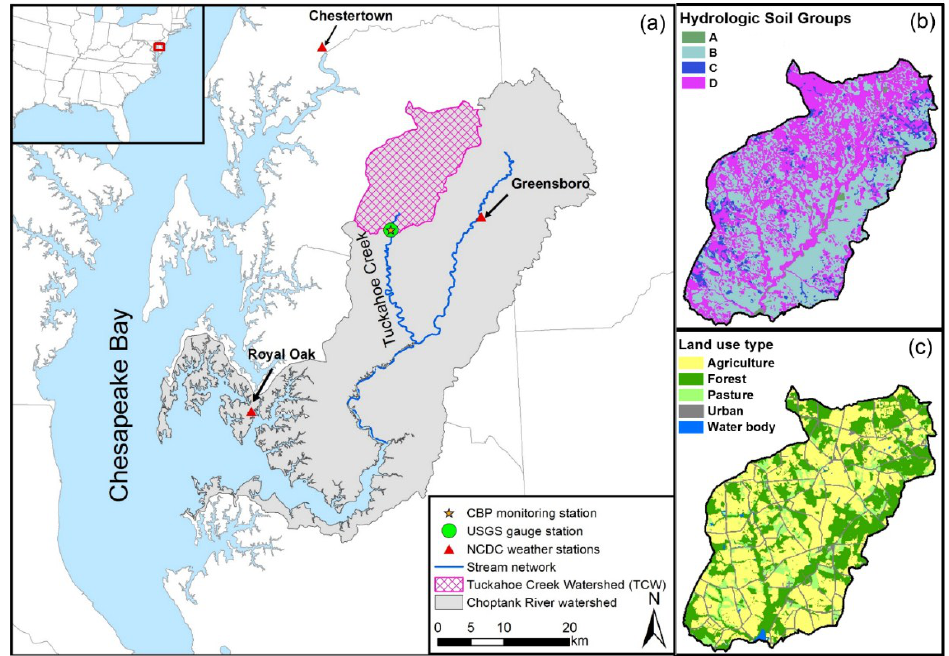
Figure 1. Location ( a ) soil ( b ) and land use ( c ) of the Tuckahoe Creek Watershed (adapted from [22]). HSGs are characterized as follows: A—well-drained soils with 7.6–11.4 mm/h water infiltration rate;